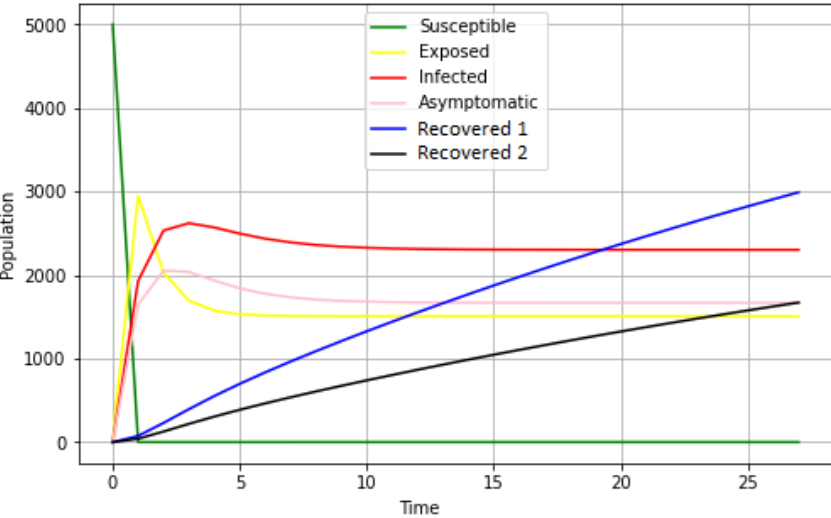
Figure 5. General dynamics of the disease with